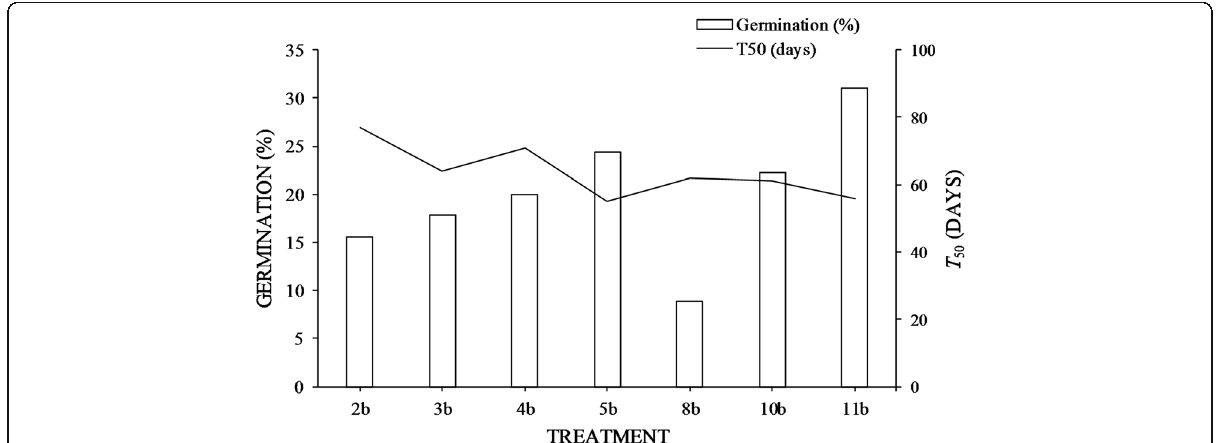
Fig. 1 Mean (±SEM) germination percentage (G%) and time to 50% germination ( T 50 ) under GA 3 and KNO 3 treatments at 25 °C. (Treatments: 2b = 500 mg L − 1 , 3b = 1000 mg L − 1 , 4b = 2000 mg L − 1 , 5b = 3000 mg L − 1 , 8b = 1.5% KNO 3 , 10b = 200 mg L − 1 GA 3 + 0.5% KNO 3 , 11b = 500 mg L − 1 GA 3 + 1% KNO 3